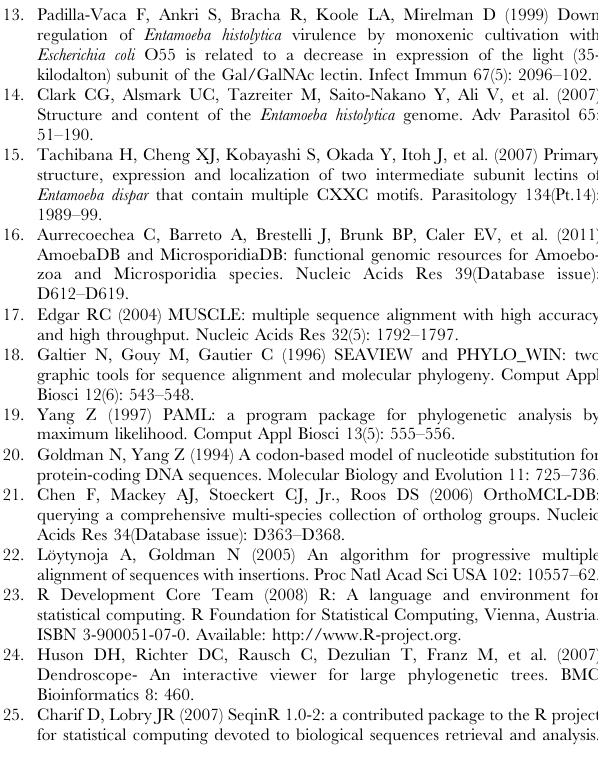
Figure S1 Divergence across chromosomal regions genes of E. histolytica and E. dispar containing heavy- chain lecin genes. (A) hgl (EHI_012270:EDI_213670); (B) hgl (EHI_046650:EDI_123980). Divergence ( d ) for a 200 bp sliding window is shown (black line), and dN (blue bars) and dS (red bars) are plotted for putative coding regions. The grey line shows the proportion of gapped positions in each window, an indication of poor alignment quality. dS is not notably greater for lectin genes than for surrounding genes. In panel B, bases between position 8000–14,000 could not be aligned so were replaced with Ns (hence the apparent sequence identity in the plot). (PDF) Figure S2 Nucleotide alignment of orthologous genome regions of E. histolytica and E. dispar used to estimate inter-specific divergence around the heavy chain lectin orthologues EHI_012270 and EDI_213670. (PDF) Figure S3 Nucleotide alignment of orthologous genome regions of E. histolytica and E. dispar used to estimate inter-specific divergence around the heavy chain lectin orthologues EHI_046650 and EDI_123980. (PDF) Figure S4 Nucleotide alignment of orthologous genome regions of E. histolytica and E. dispar used to estimate inter-specific divergence around the intermediate chain lectin orthologues EHI_006980 and EDI_276450. (PDF) Figure S5 Nucleotide alignment of orthologous genome regions of E. histolytica and E. dispar used to estimate